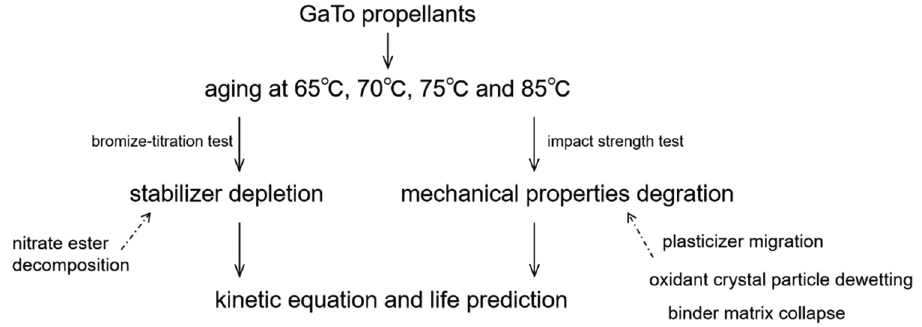
Figure 1: The experimental scheme of GaTo accelerated aging